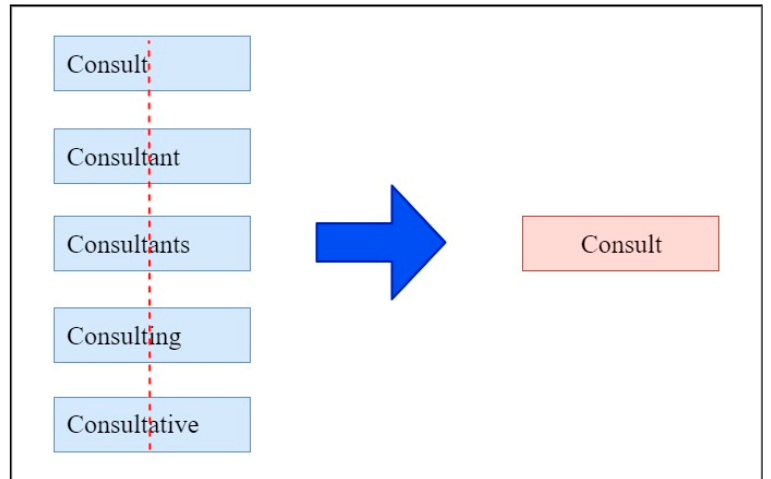
Figure 6. Example of